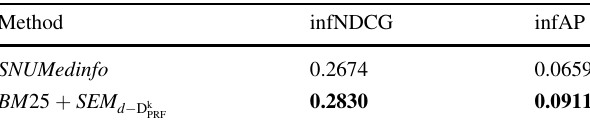
Table 6 Comparison to SNUMedinfo , the best automatic run in the TREC 2014 CDS task